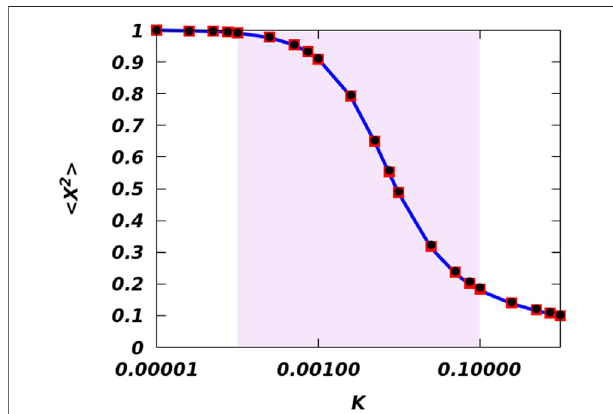
(cid:3)(cid:3) √ N ).It